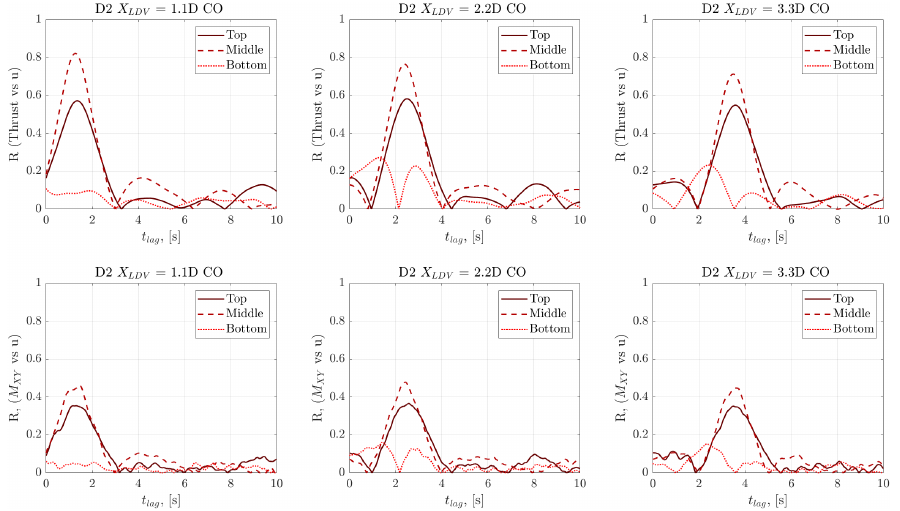
Figure 10. Development of the cross-covariance coefficient at differing lag values between LDV measurements and rotor torque meaurements. Upper charts show the thrust, whereas the lower charts show out-of-plane ( M XY ) BRBM correlations with the fluid velocity